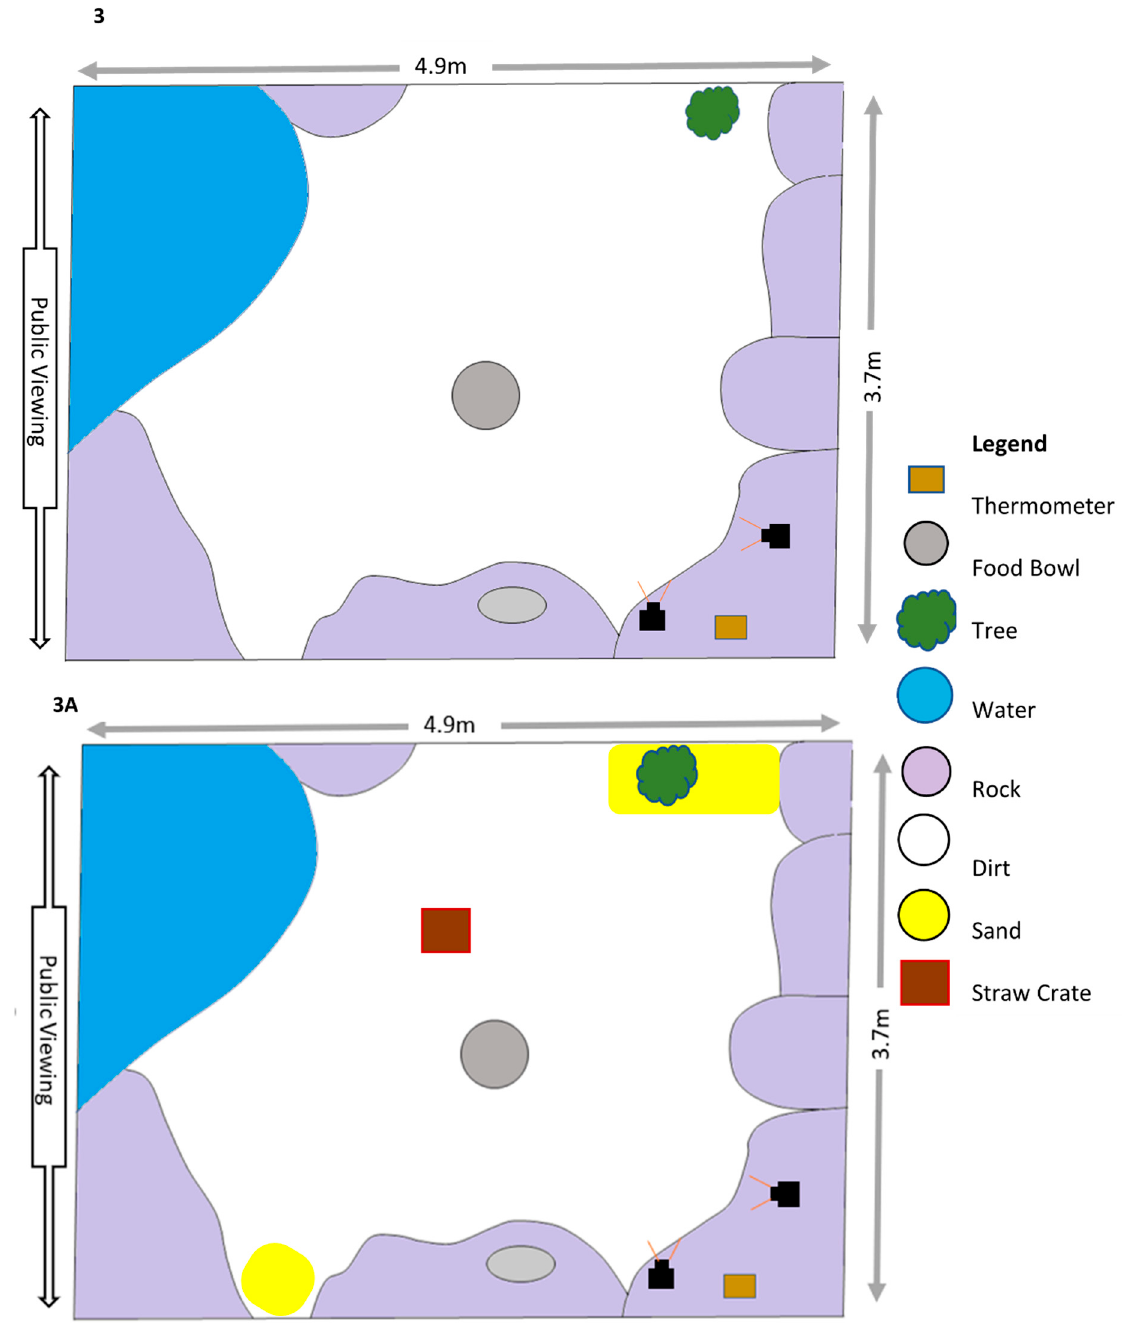
Figure A4. Diagram of Enclosure 3 & 3A. Enclosure 3 top is the unchanged enclosure for the Aldabra tortoises, enclosure 3A bottom is the changes enclosure for the Aldabra tortoises, with camera place- ment.